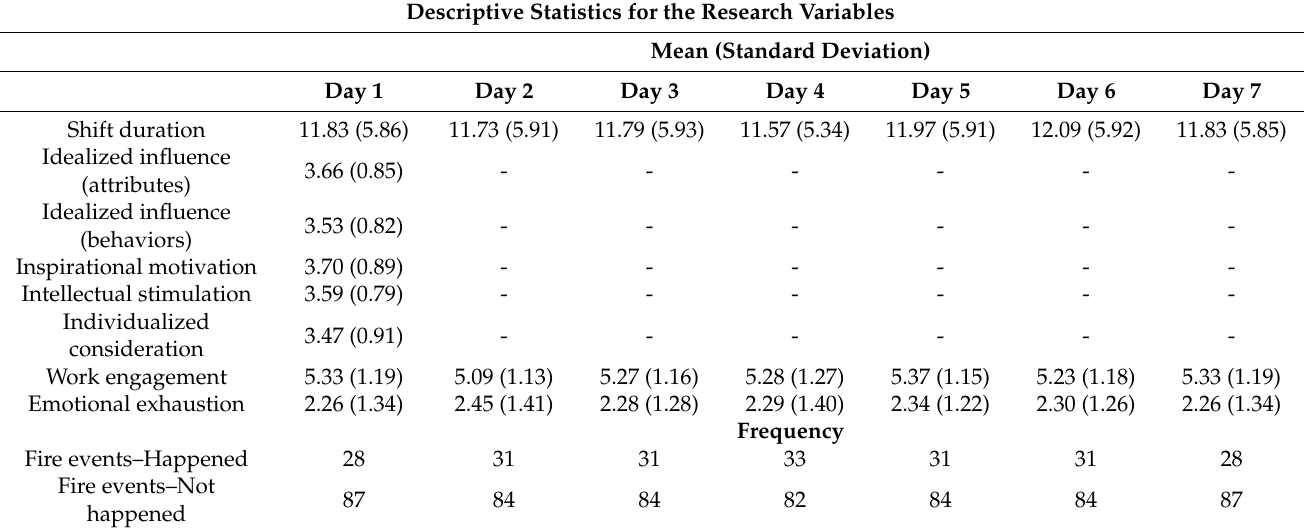
Table 2. Provides the Descriptive Statistics for the Research